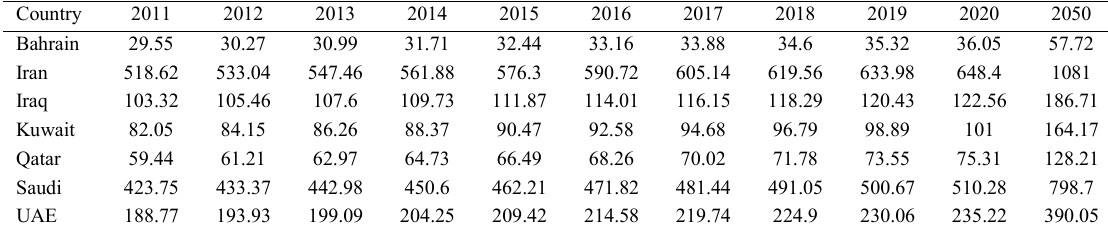
emission from 2011 to 2050 2